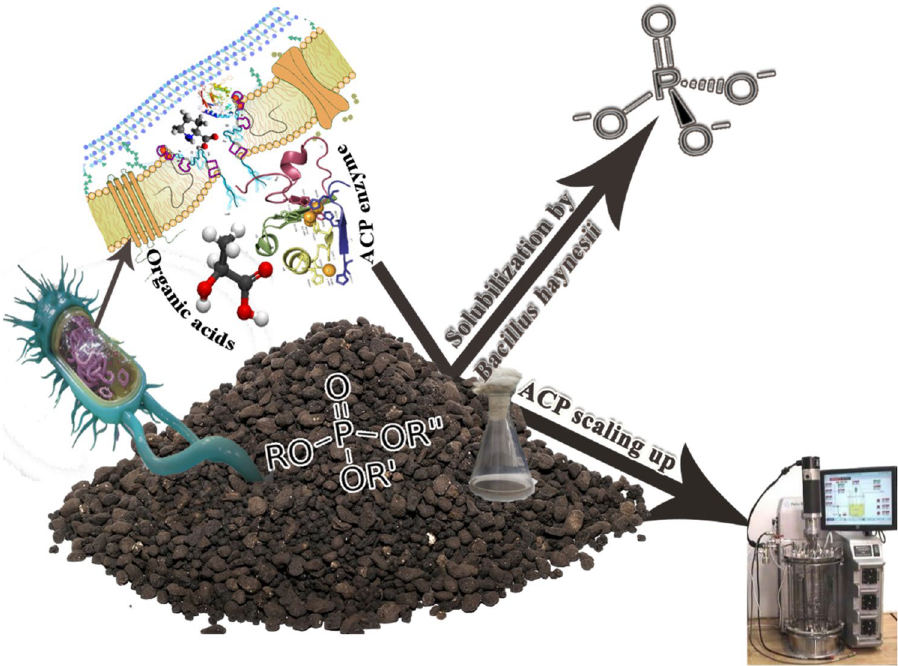
Figure 1. Schematic diagram showing the ultimate benefit utilization of characteristic features of new- discovered B. haynesii strain ACP1 for bio-solubilization of RP and boosting the production of ACP on bench- top bioreactorscale.